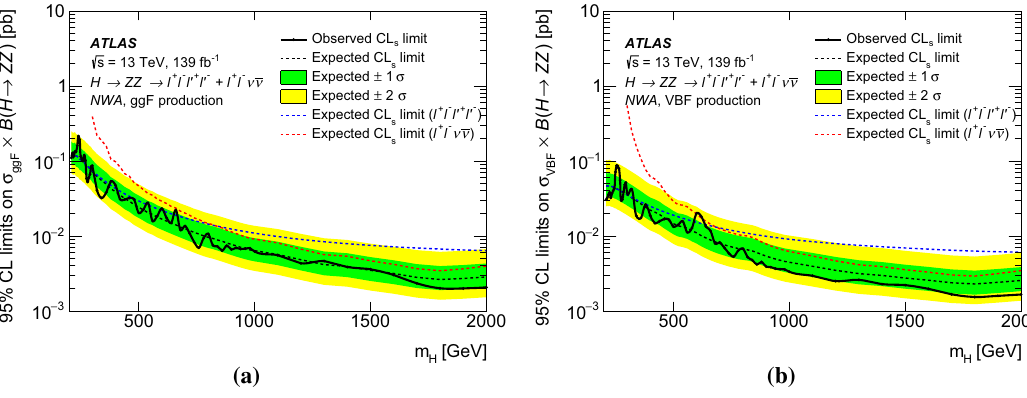
Fig. 4 The upper limits at 95% CL on the cross section times branch- ing ratio as a function of the heavy resonance mass m H for a the ggF production mode ( σ ggF × B ( H → Z Z ) ) and b for the VBF production mode ( σ VBF × B ( H → Z Z ) ) in the case of the NWA. The black line